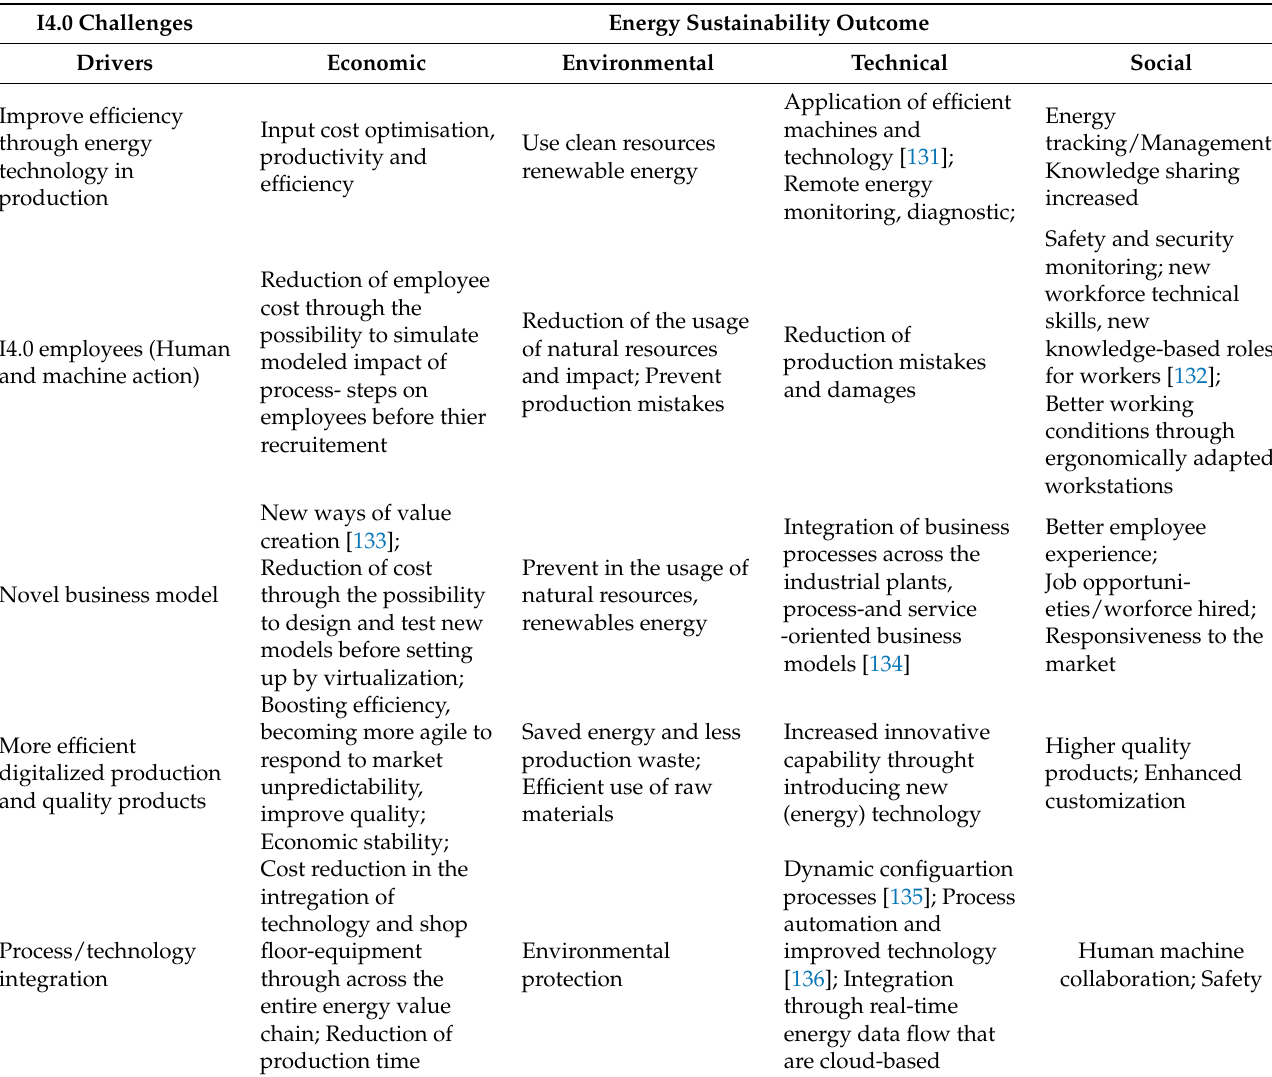
Table 11. I4.0 challenges supporting the sustainability